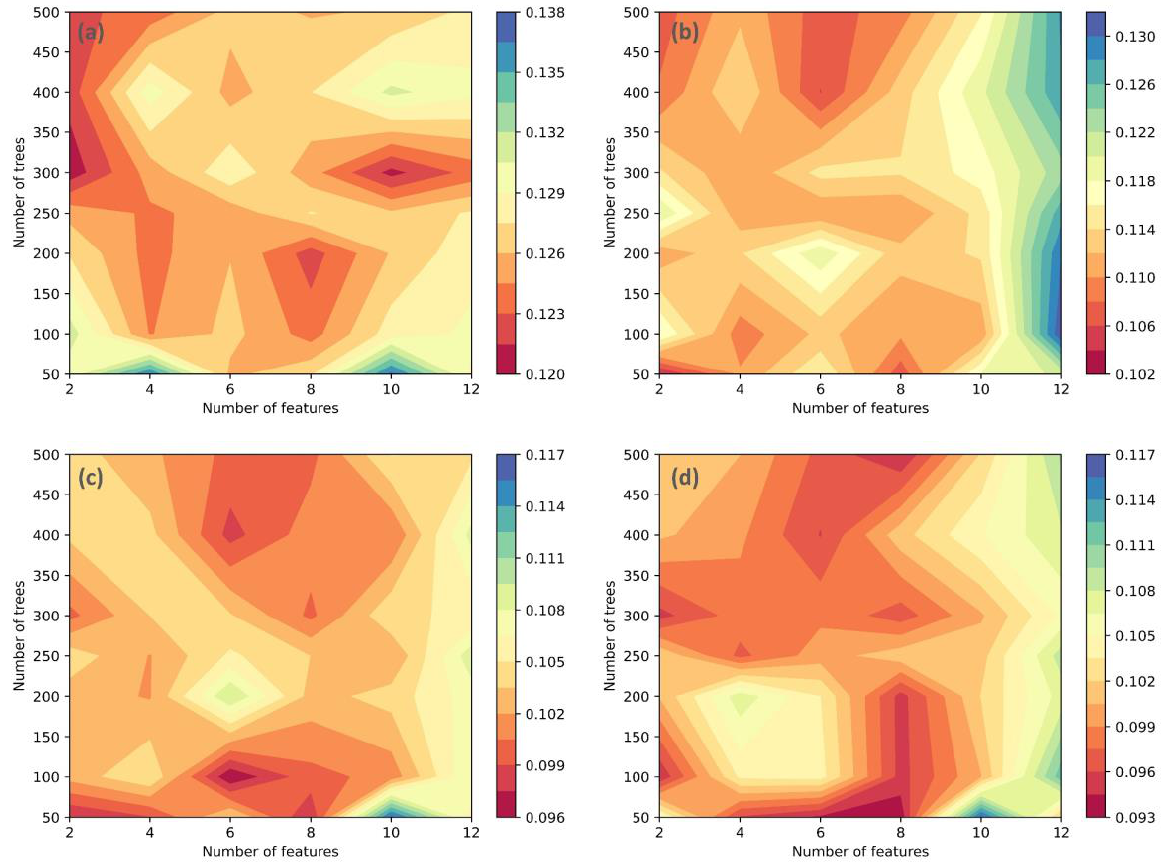
Figure 11. Contour maps showing the sensitivity of RF model based on MSE results obtained by training different datasets; the number of trees and number of features employed for training RF models based on: ( a ) Landsat-8; ( b ) Sentinel-2; ( c ) ASTER; ( d ) data integration.